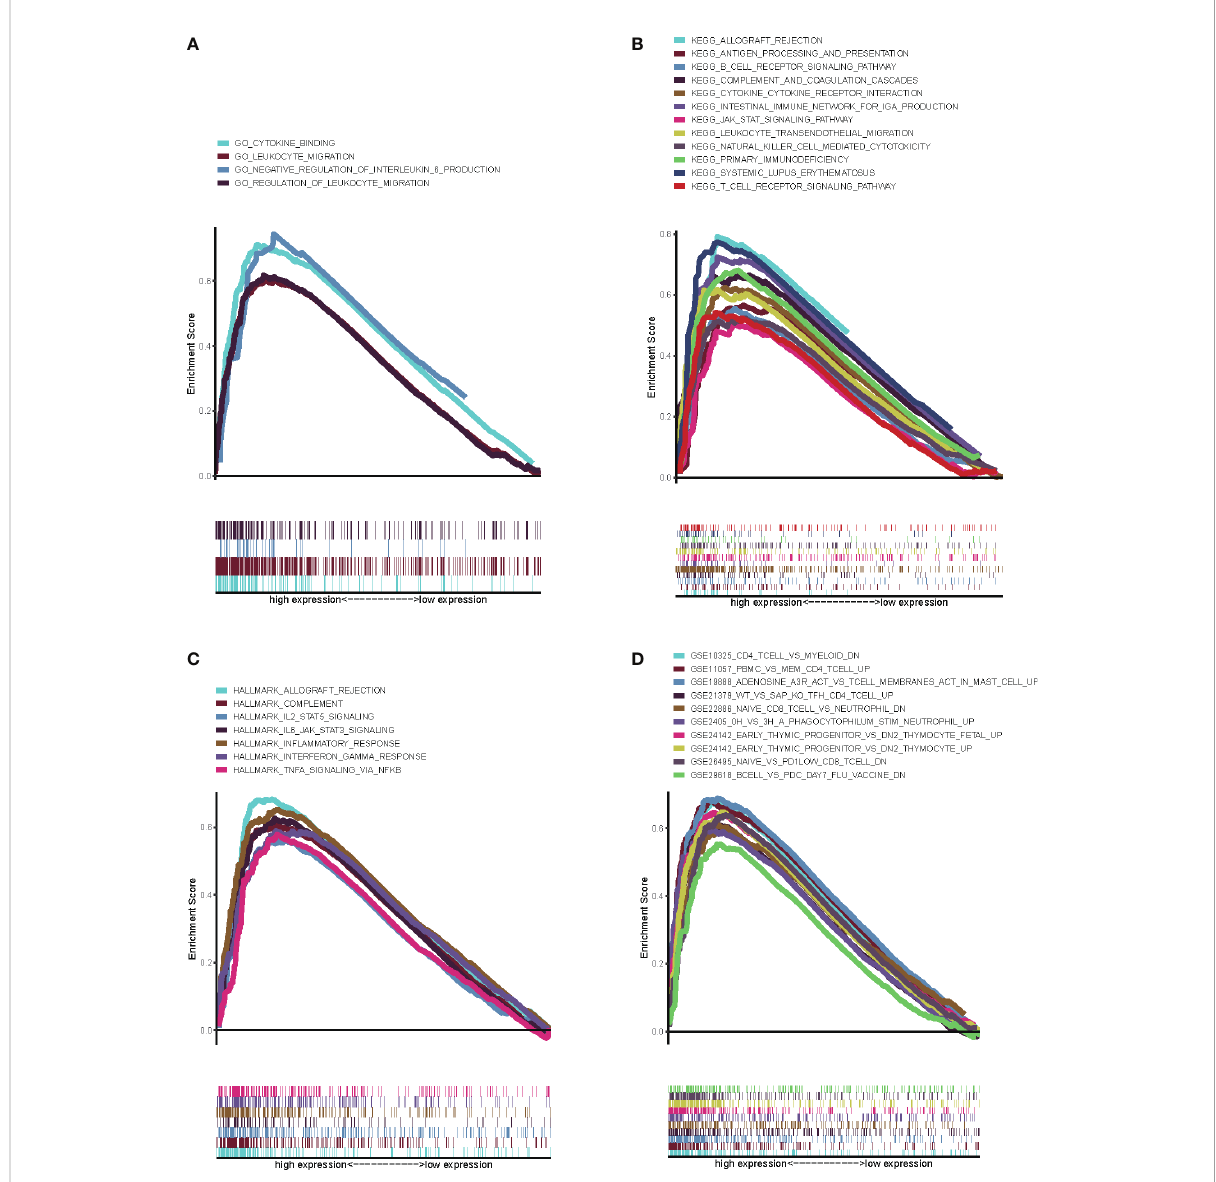
FIGURE 6 GSEA for genes in high CXCL12 expression group. (A) GSEA for genes in high CXCL12 expression group in C5 collection, the gene ontology sets; (B) GSEA for genes in high CXCL12 expression group in C2 collection, the KEGG gene sets database; (C) GSEA for genes in high CXCL12 expression group in hallmark gene sets; (D) GSEA for genes in high CXCL12 expression group in C7 collection de fi ned by MSigDB, the immunologic gene sets. FDR<0.05 and p<0.05 were considered to be statistically signi fi